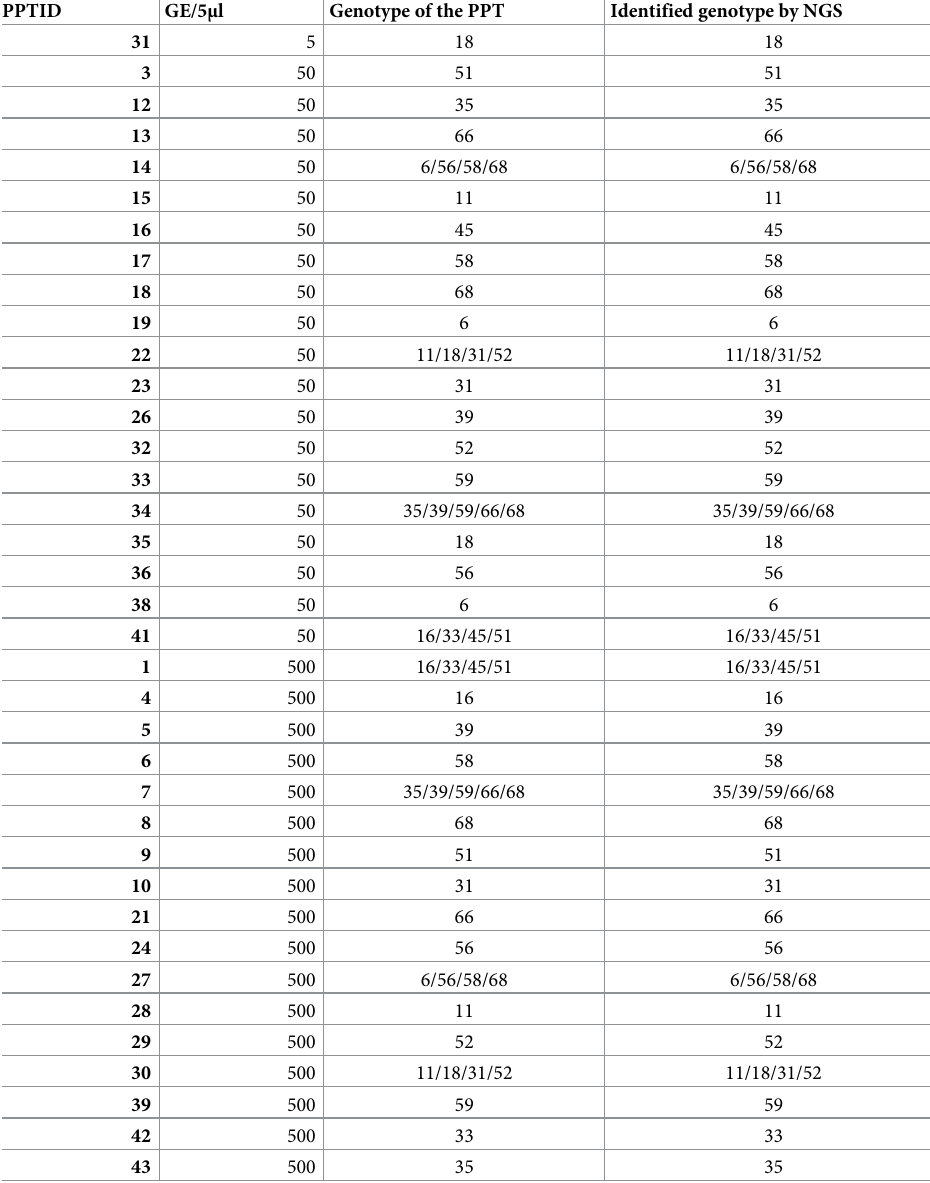
Table 1. Proficiency test panel genotyping using NGS technology. PPTID GE/5 μ l Genotype of the